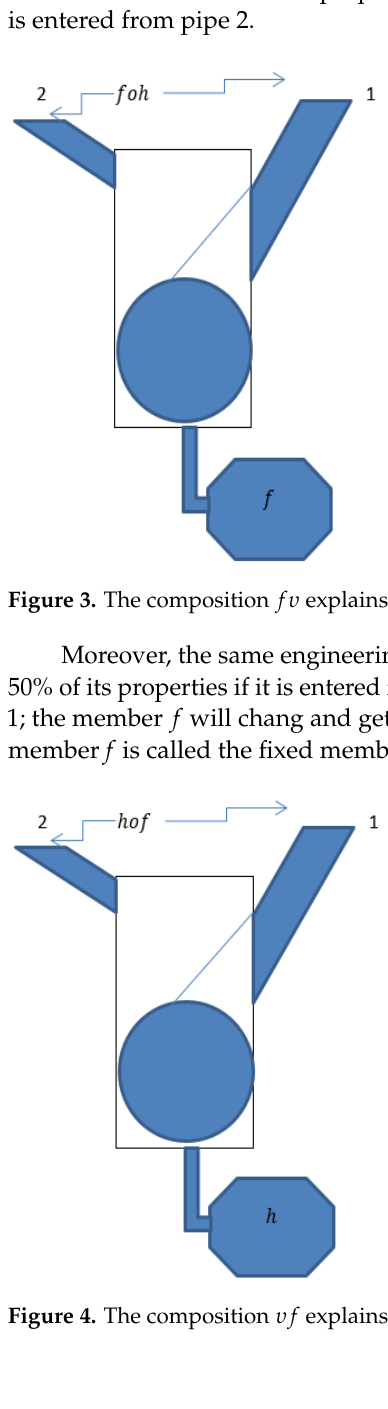
Figure 4. The composition 𝜐𝜊𝑓 explains when 𝑓 is entered from pipe 2.